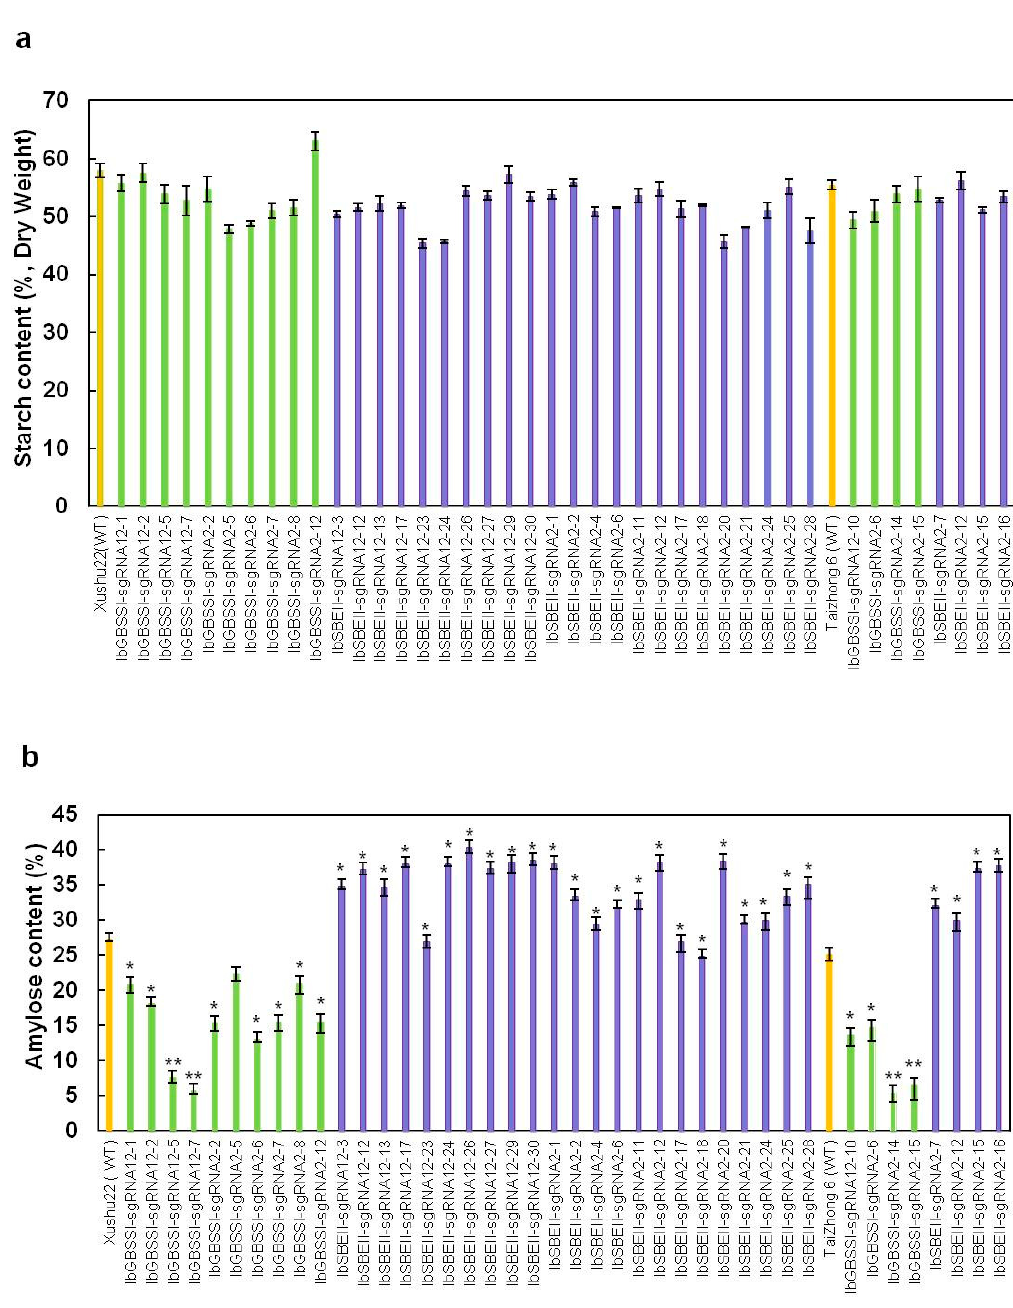
Figure 4. Total starch and amylose contents in transgenic lines produced using CRISPR / Cas9 systems. ( a ) Total starch content in storage roots of wild-types (Xushu22 and Taizhong6) and transgenic plant lines. ( b ) Amylose contents in storage roots of wild-types (Xushu22 and Taizhong6) and transgenic plant lines. Significance was determined by the Student’s t-test at * p < 0.05.